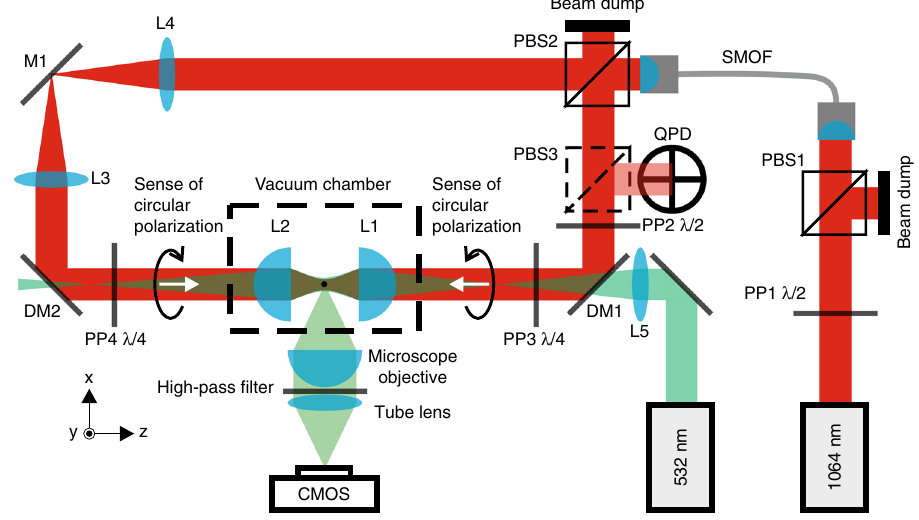
Fig. 4 Schematic showing the optical set-up. A detailed description is provided in the